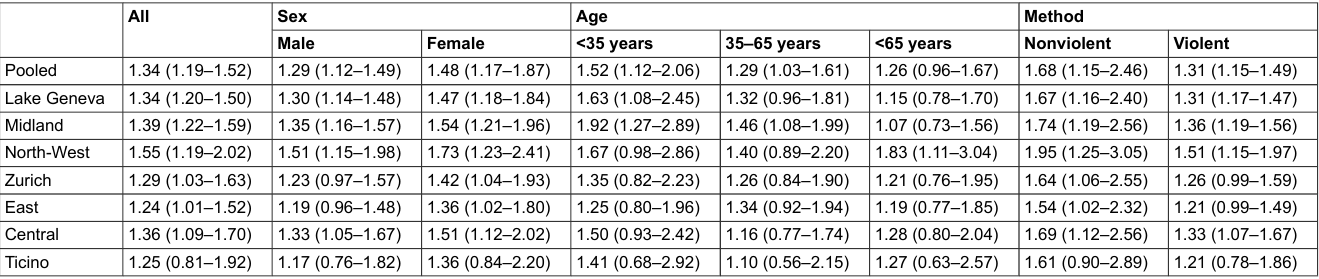
Table 2: Temperature-suicide association.